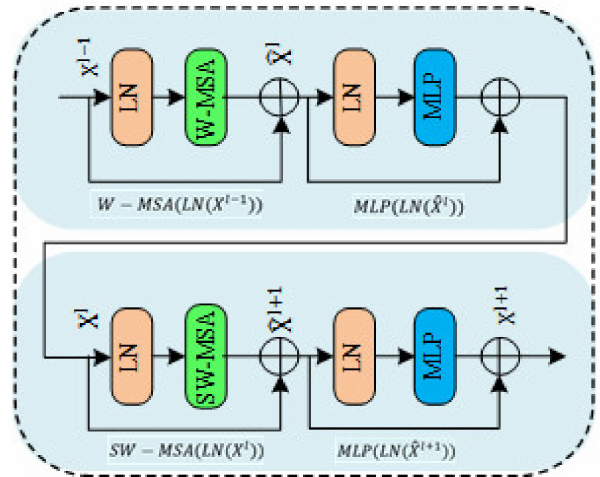
Figure 3. Two successive swin transformer